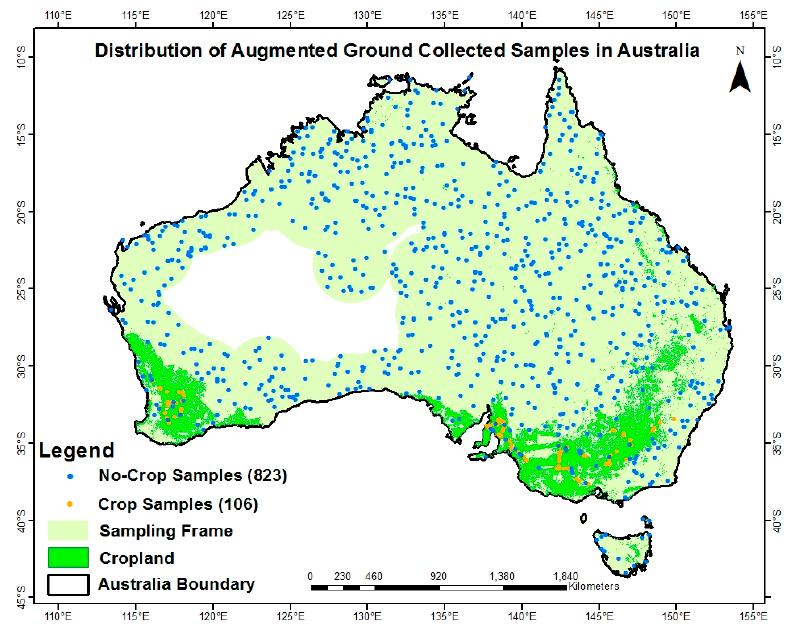
Figure 12. The distribution of ground collected and augmented no-crop samples in Australia.